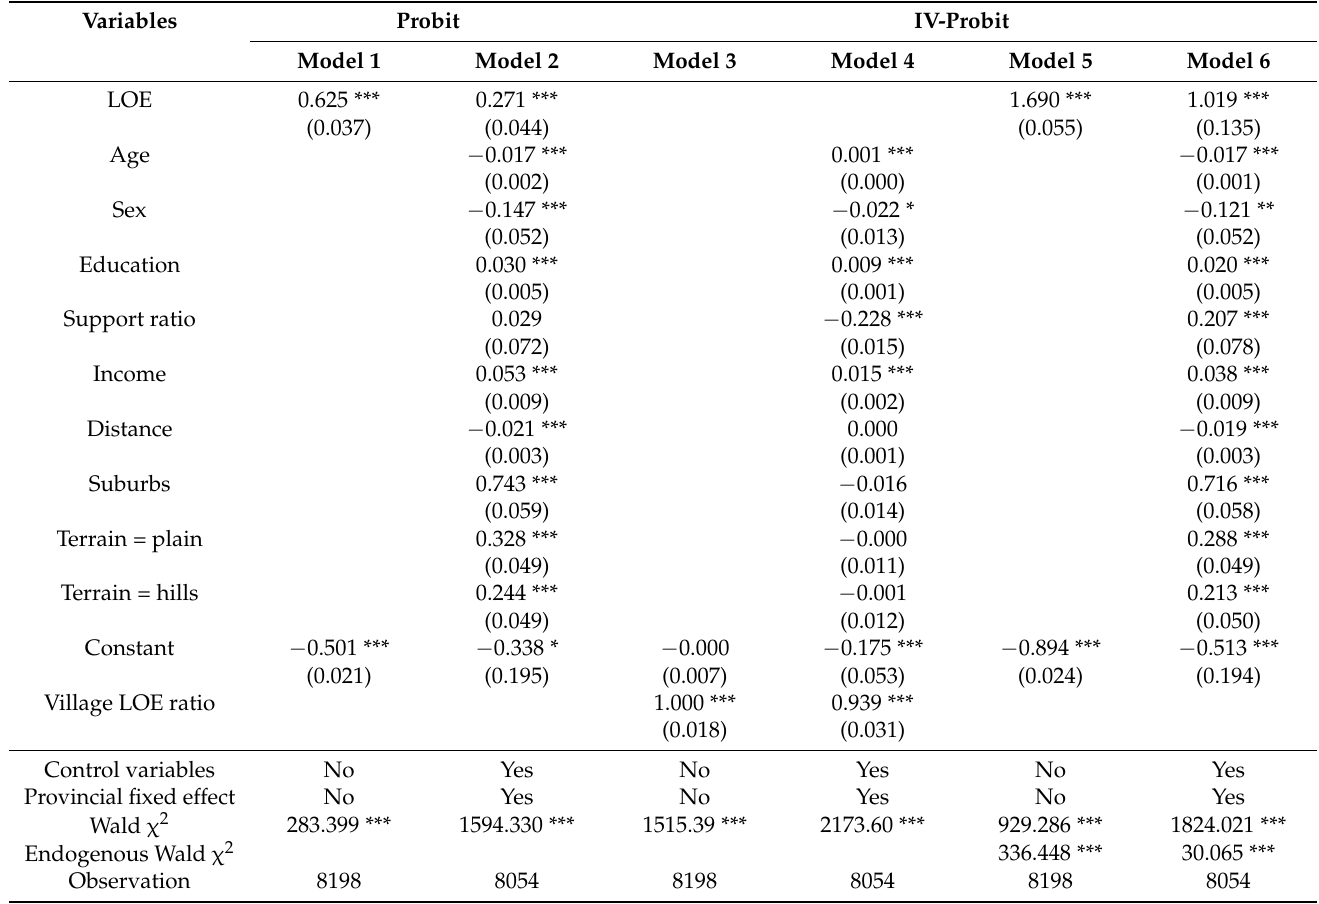
Table 2. Impact of off-farm employment on clean energy